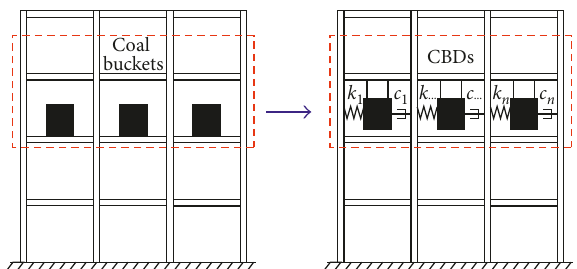
Figure 1: Simplified model of a coal-fired power plant building. (a) Traditional power plant. (b) Power plant with